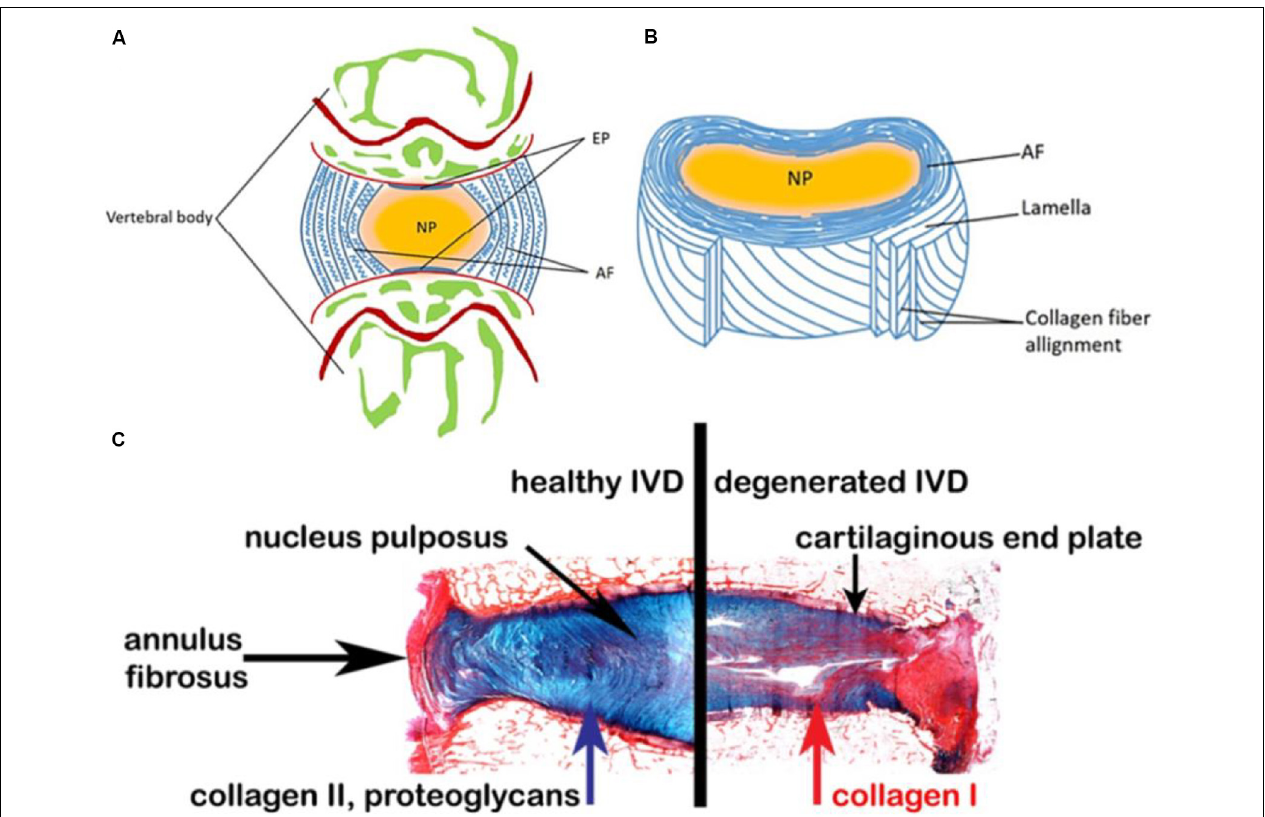
FIGURE 1 | Schematic representations of the adult IVD. (A) Midsagittal cross-section showing anatomical regions. (B) Three-dimensional view of the AF lamellar structure. (C) Comparison of a healthy human disk and a degenerated disk. Reproduced from Sakai and Andersson (2015); Eyre and Muir (1976) with permissions from Copyright 2015 AO Research Institute and 2019